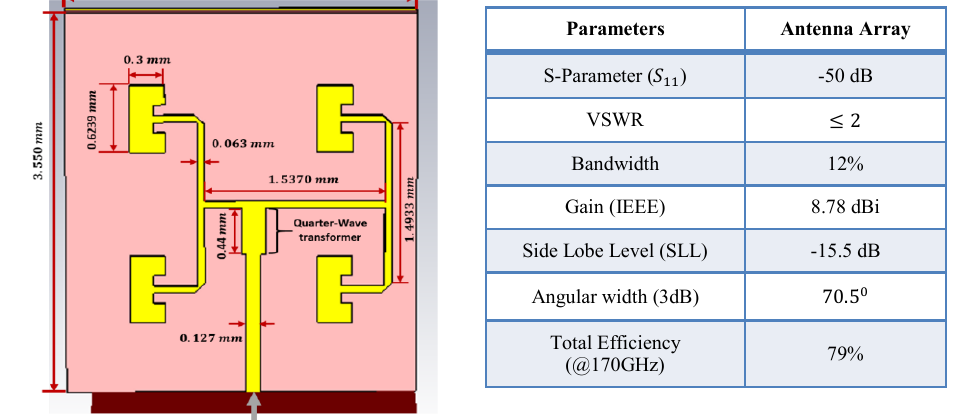
Figure 2: CST model of inset-fed directional microstrip patch antenna 2×2 array for 170 GHz resonant frequency.